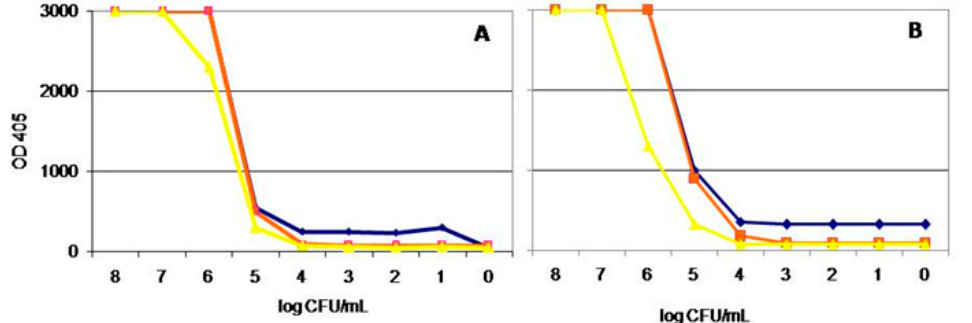
Figure 1. Sensitivity reached by MAb 2G1/PPD by DAS-ELISA ( A ) and by commercial polyclonal antibodies from Loewe ( B ) in almond (orange color) and olive (yellow color) tree extracts spiked with serial 10dilutions of the X. fastidiosa strain IVIA 5235. In blue color dilutions in PBS are represented.